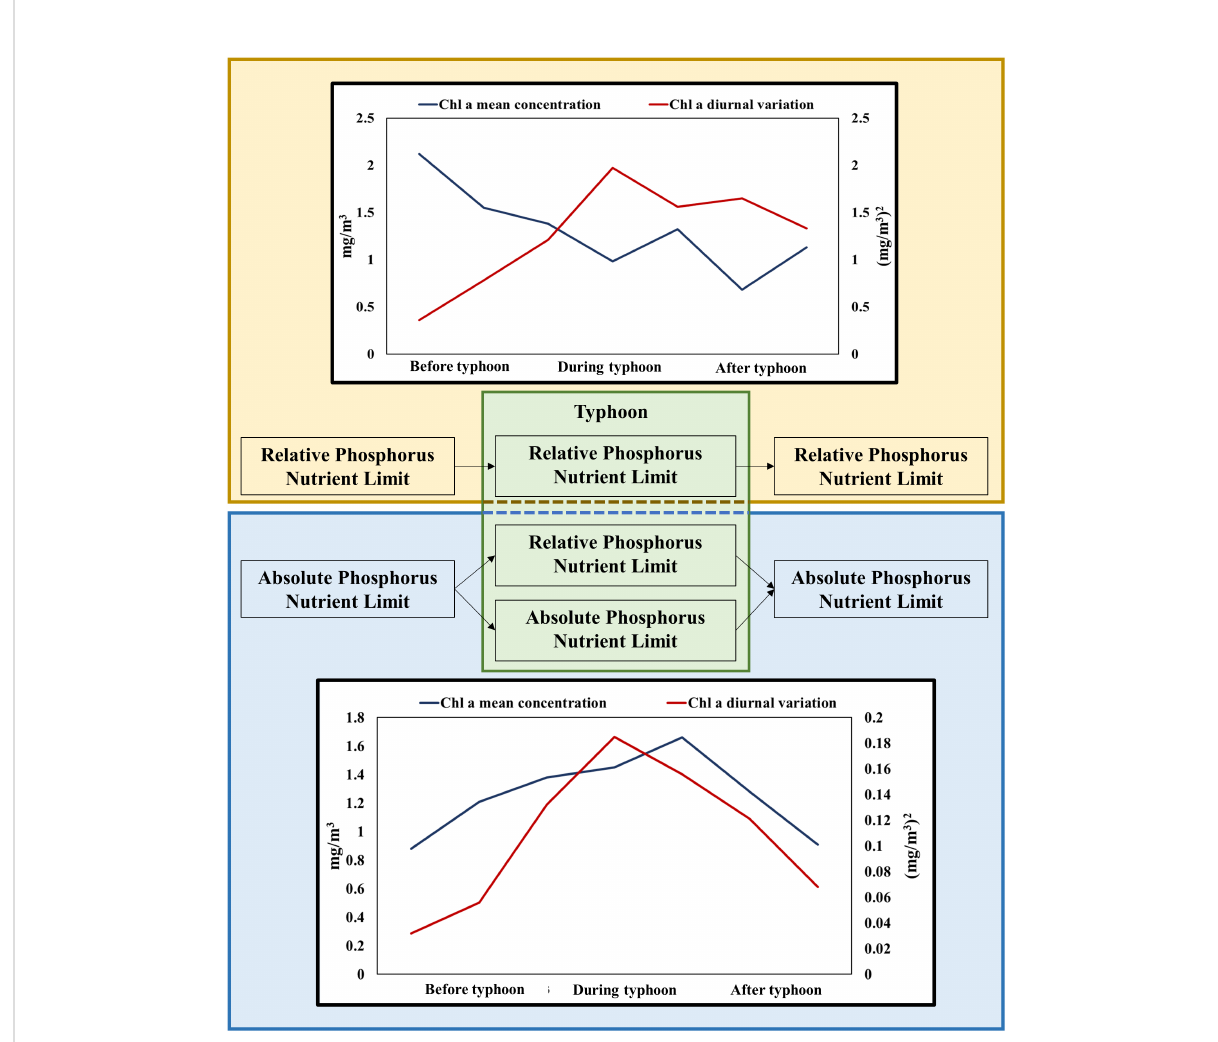
FIGURE 2 Scienti fi c hypothesis of chlorophyll concentration and diurnal changes before and after typhoon. The large background boxes in yellow and blue represent the hypotheses of changes in two different nutrient-limited status